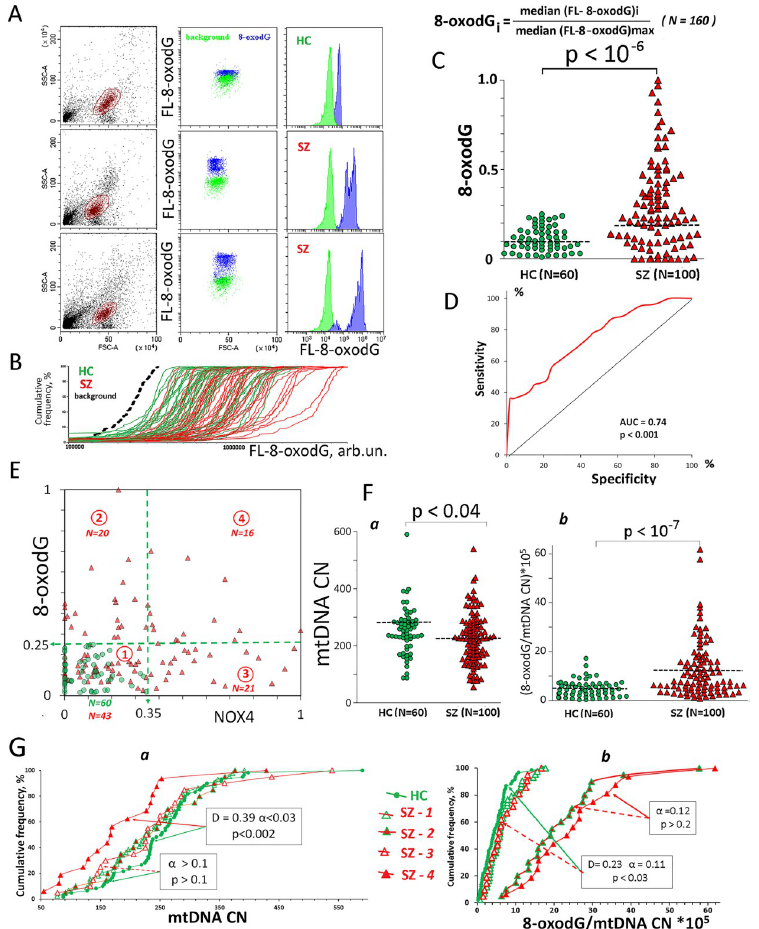
Fig 2. 8-oxodG levels in the PBL of the SZ group and HC group. A. The most typical examples of the 8-oxodG analysis in lymphocytes. B. Cumulative distribution of FL1-8-oxodG for 103 randomly selected HC (green) and SZ (red) samples in a single experiment. The dashed curve is the background curve for the sample with the maximum background level. C. 8-oxodG levels in the lymphocyte of the SZ- and HC groups. The average level of marker in the cell population was estimated by the FL-signal median value. In the graphs, each point is the mean for three FL-signal median values (three parallel measurements for the same PBMC sample). The median values were normalized to the maximum signal medians values in the analyzed total sample (N = 160). The relative standard error was 7 ± 2%. The significance of the observed differences was analyzed using non-parametric Mann–Whitney (p) test. D. ROC curve. Each point on the ROC curve represents a sensitivity/specificity pair. The area under the ROC curve (AUC) is a measure of how well a parameter can distinguish between two groups (SZ/HC). E. The dependence of 8-oxodG on NOX4 . Dotted lines indicate areas of points included in the SZ subgroups. F. (a) MtDNA CN in the HC and SZ groups. (b) Ratio 8-oxodG/mtDNA CN for the HC and SZ groups. G. (a) Cumulative distribution of mtDNA CN for HC and SZ subgroups. (b) Cumulative distribution of ratio 8-oxodG/mtDNA CN for HC and SZ subgroups. Arrows indicate compared subgroups. The significance of the observed differences was analyzed using the non-parametric Mann–Whitney test (p) and Kolmogorov–Smirnov test (D and α